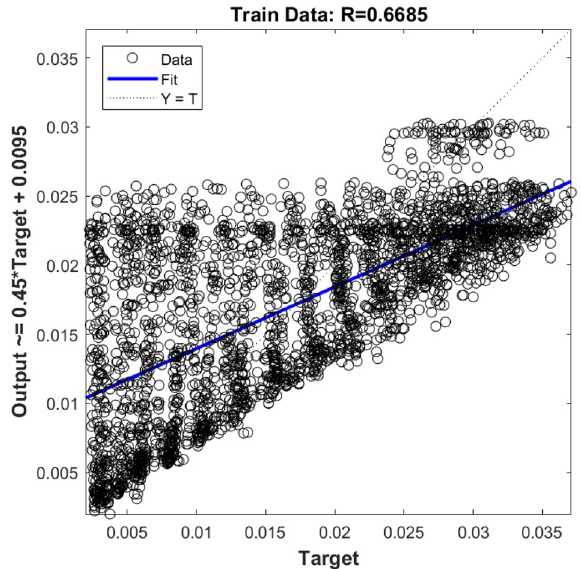
Figure 8. Training validation of liquid velocity for the ANFIS model with two inputs (x and Y computing nodes, the position of numerical elements). The ANFIS model’s output is the liquid velocity distribution, and it is validated against the velocity component (x-direction) in the CFD calculation (target value).